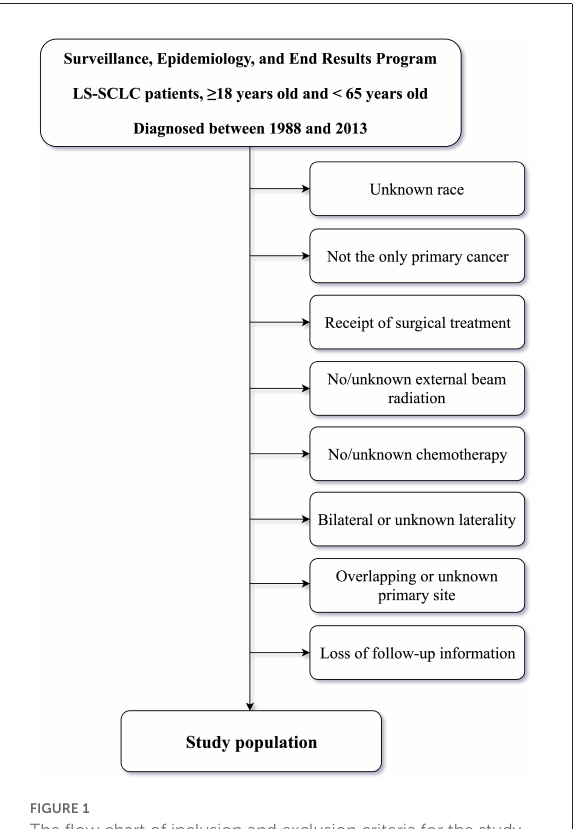
FIGURE1 The flow chart of inclusion and exclusion criteria for the study population.